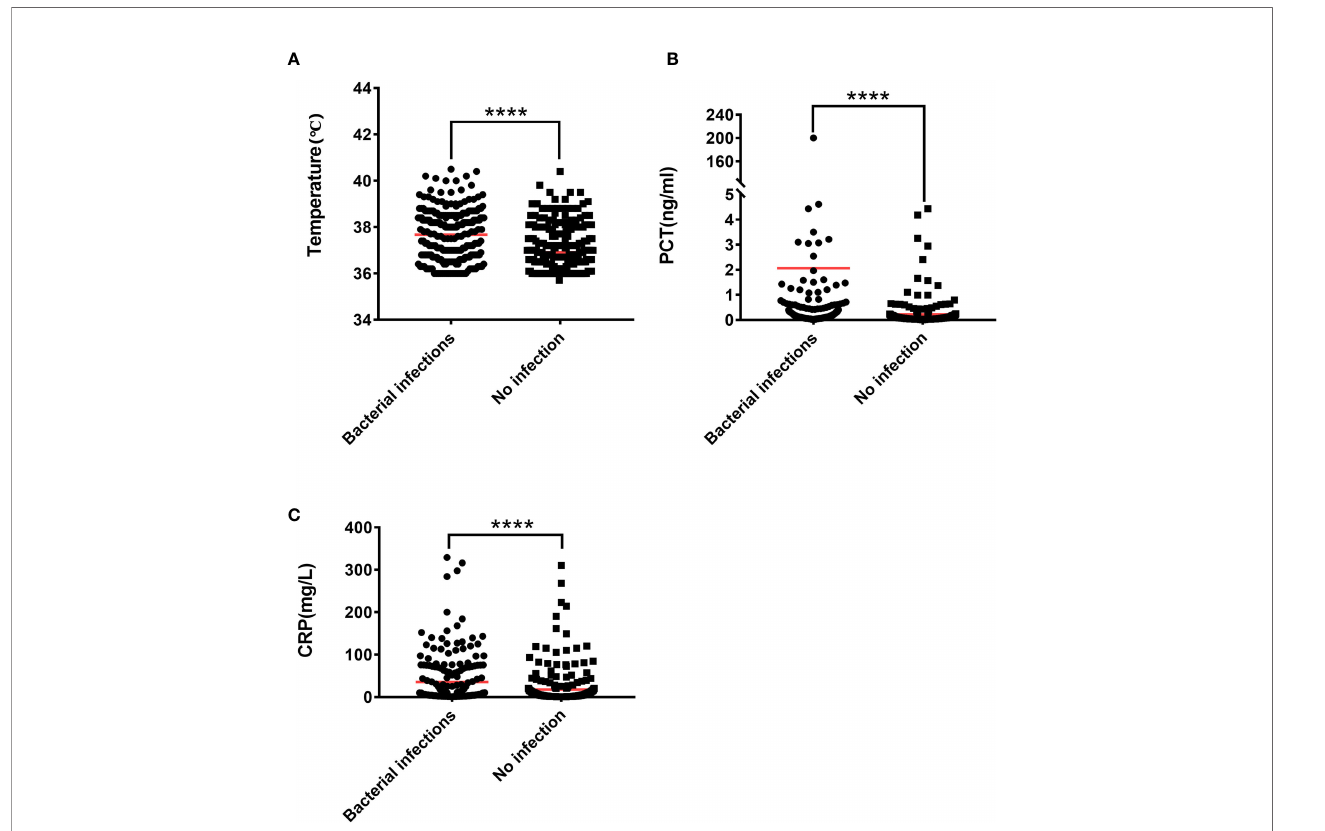
FIGURE 1 | The Mann-Whitney U test is used to test the difference between patients with lung bacterial infection and those without bacterial infection. (A) Body temperature, (B) PCT, (C) CRP. ****P <